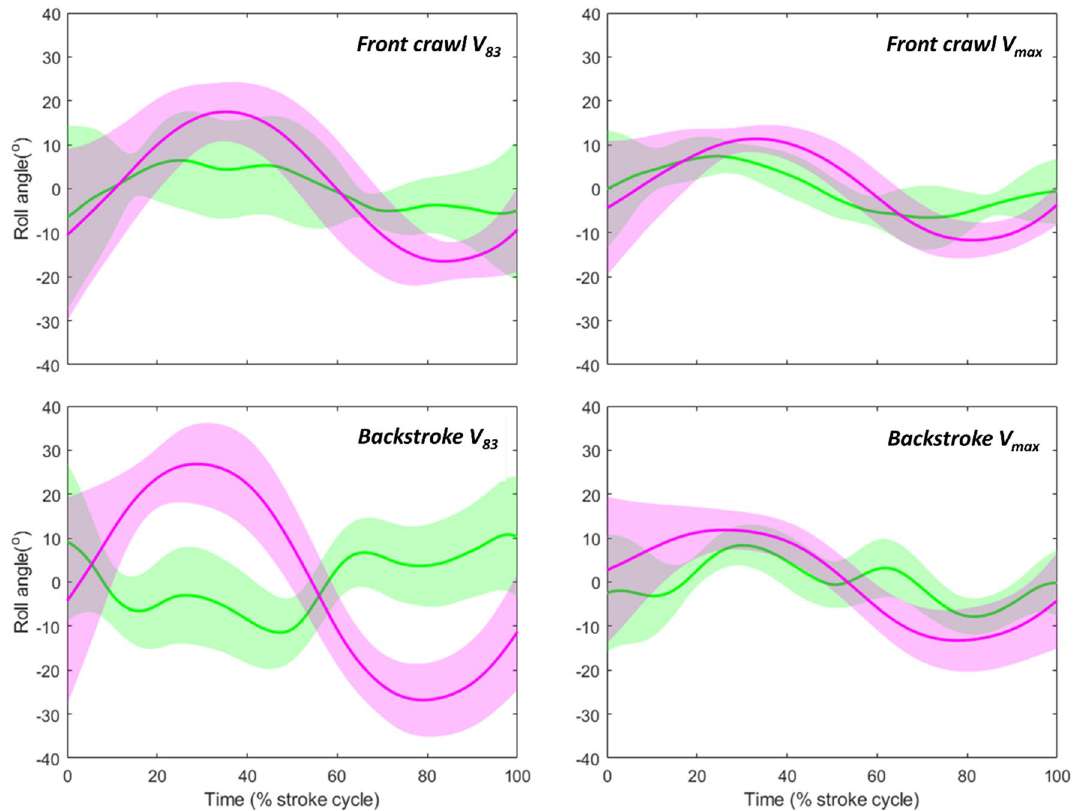
Figure 4. Whole-body roll angle due to the buoyant torque and due to the hydrodynamic torque (pink and green lines, respectively). The shaded areas show inter-participant standard